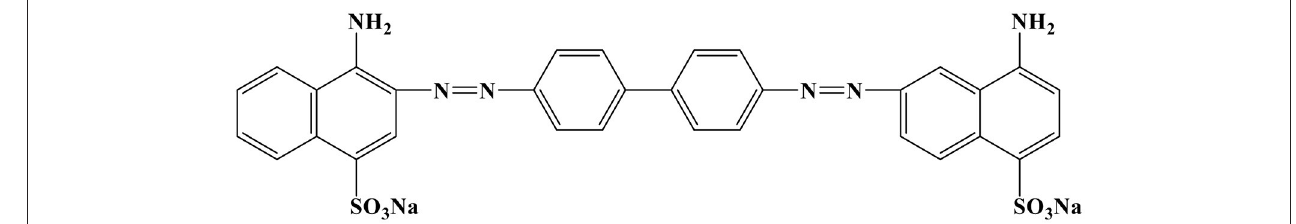
FIGURE 1 | Structure of